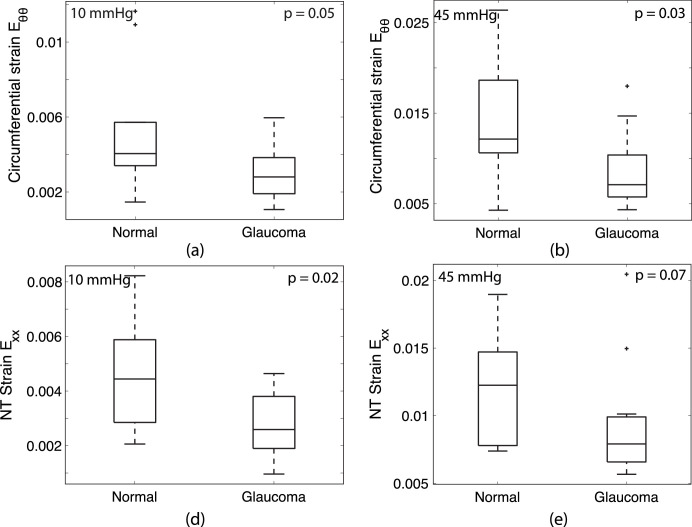
Comparison of average LC strain in normal and glaucoma eyes showing (A) Eθθ at 10 mm Hg, (B) Eθθ at 45 mm Hg, (C) EXX at 10 mm Hg, and (D) EXX at 45 mm Hg.